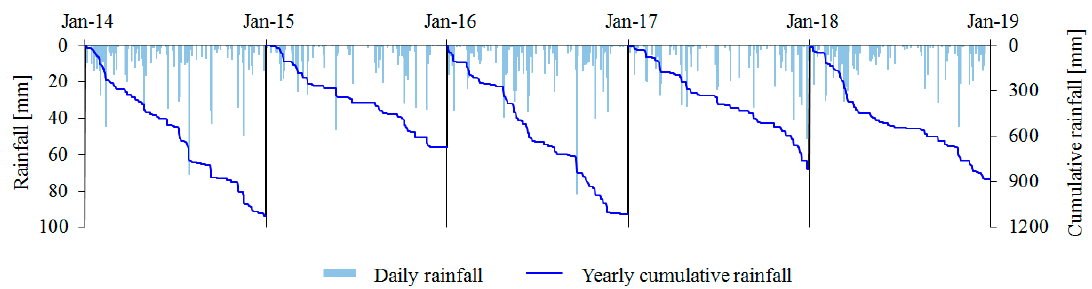
Figure 2. Rainfall regime of the area of interest in the period 2014–2018.